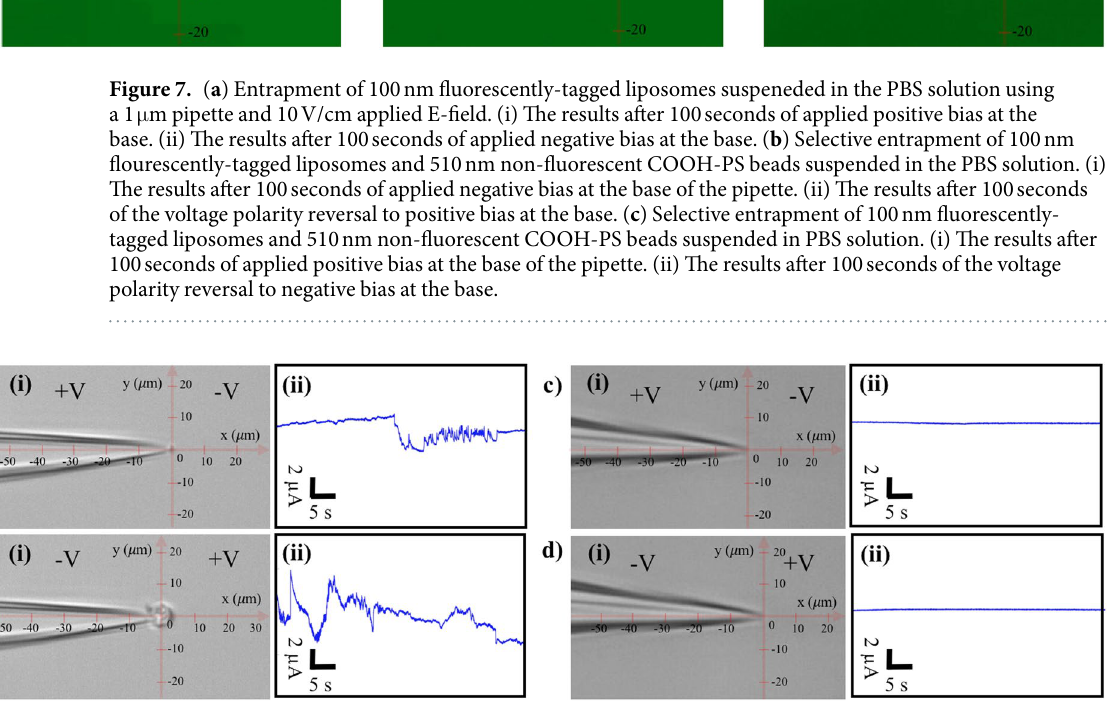
Figure 8. ( a ) (i) Trapping results of plasma-driven exosomes re-suspended in the PBS solution with positive potential applied at the base of the pipette after 100 seconds. ( a ) (ii) Corresponding conductance changes across the pore. ( b ) (i) Trapping results of exosomes after reversal of the voltage polarity to the negative potential at the base of the pipette after 100 seconds. ( b ) (ii) Corresponding conductance changes across the pore. ( c – d ) The blank control experiments without exosomes and the corresponding conductance measurements across the pores. The diameter of the pipette was 1 μ m and the applied E-field was 10